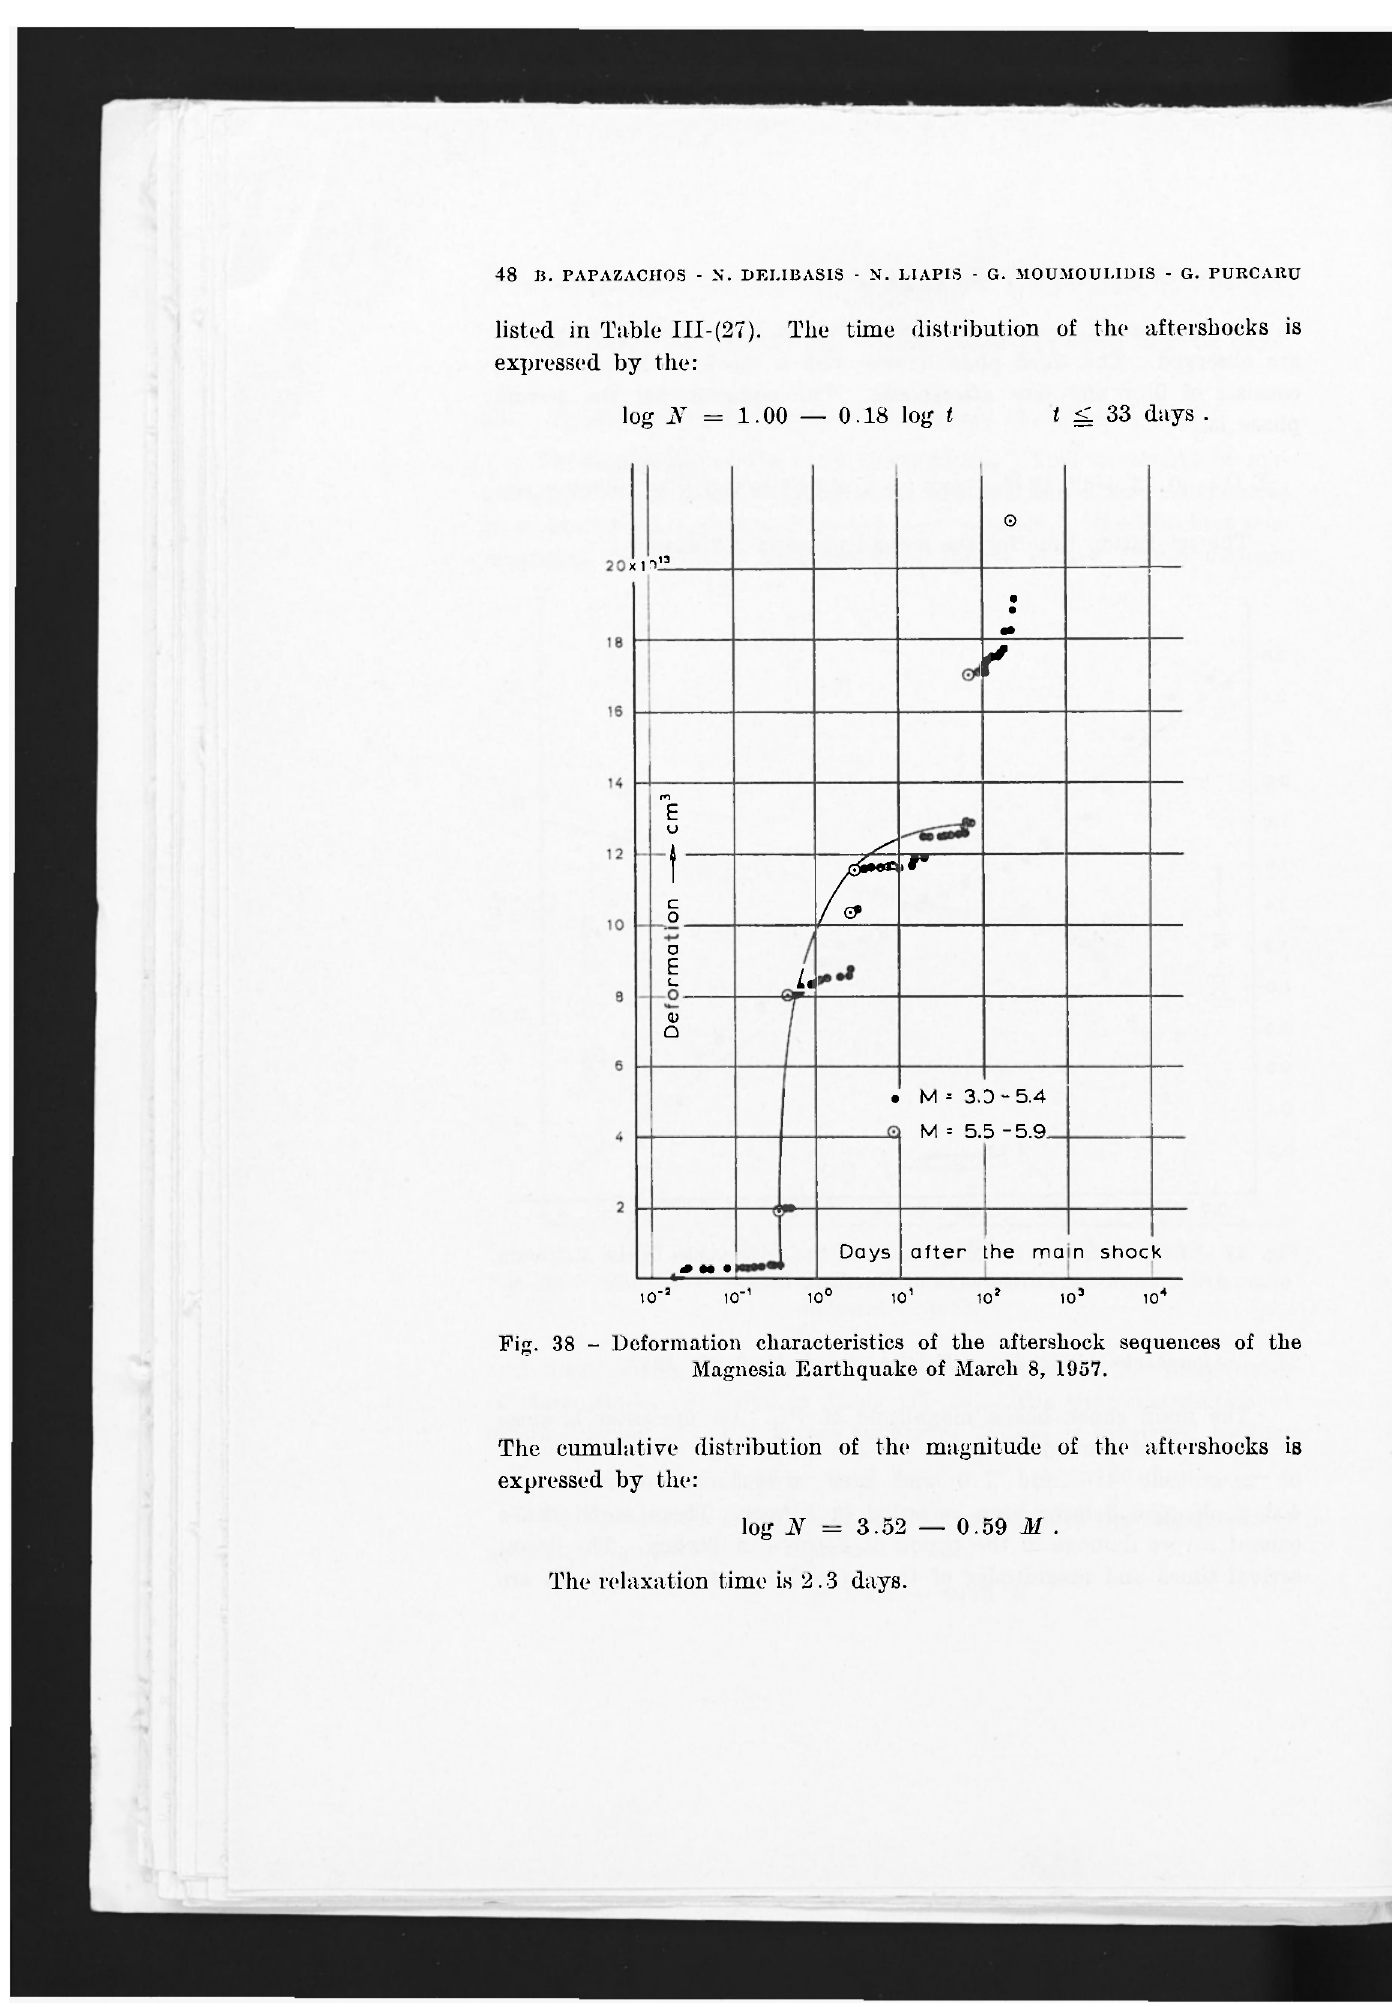
Fig. 38 - Deformation characteristics of the aftershock sequences of the Magnesia Earthquake of March 8,